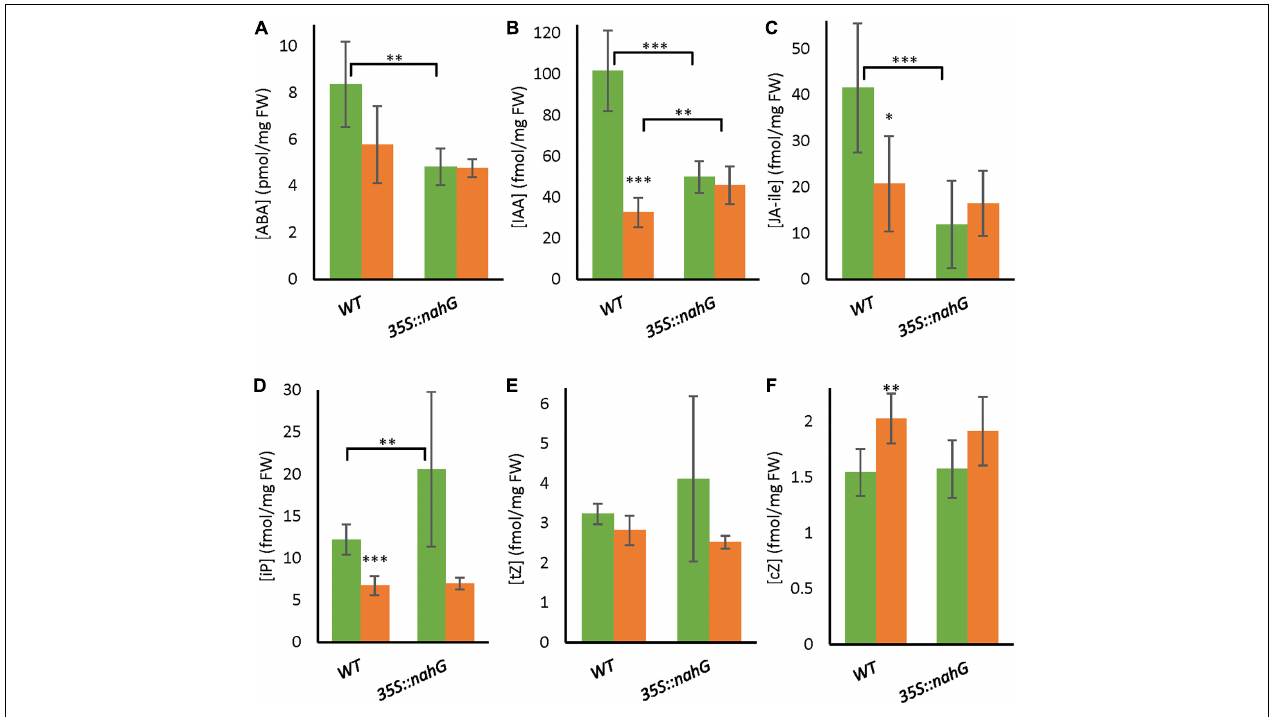
FIGURE 5 | Hormone levels in bicellular pollen stage anthers of WT and 35S:nahG after exposure to LTMH. LTMH consisted of repeated exposure to 34 ◦ C (day) and 28 ◦ C (night). Hormone concentrations were measured after 7 days of exposure to the treatment. Green bars represent CT, orange bars LTMH. Values indicate the mean ± SD ( n = 6 samples, with pools of 20 anther cones per sample). (A) Abscisic acid (ABA) levels. Two-way ANOVA main effects: temperature P < 0.05; genotype ns; interaction P < 0.05. (B) IAA levels. Two-way ANOVA main effects: temperature P < 0.001; genotype P < 0.05; interaction P < 0.001. (C) Jasmonic acid-isoleucine (JA-ile) levels. Two-way ANOVA main effects: temperature ns; genotype P < 0.01; interaction P < 0.01. (D) iP levels. Two-way ANOVA main effects: temperature P < 0.001; genotype P < 0.05; interaction P < 0.05. (E) tZ levels. Two-way ANOVA main effects: temperature P < 0.01; genotype ns; interaction ns. (F) cZ levels. Two-way ANOVA main effects: temperature P < 0.01; genotype ns; interaction ns. ∗ Significantly different between LTMH and CT in WT or between mutant and WT within temperature treatment (brackets), one-way ANOVA with Games–Howell or LSD post hoc , P < 0.05; ∗∗ P < 0.01; ∗∗∗ P <